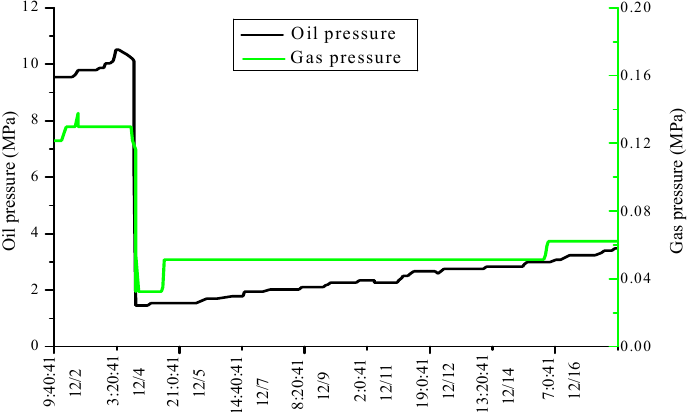
Figure 7. Real-time comparison between gas pressure and oil pressure during the mining process.